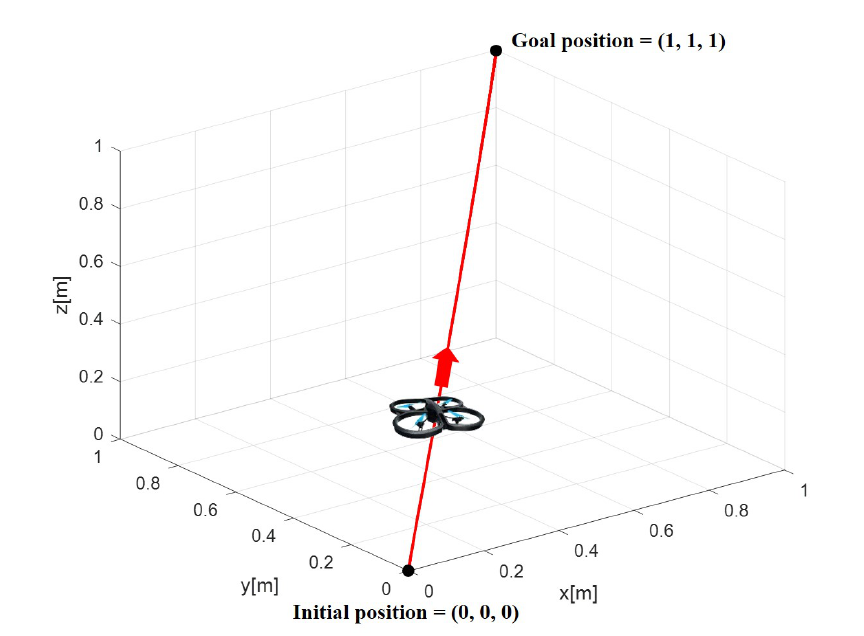
Figure 3. The inverse optimal position control when the initial and final states are (0, 0, 0) and (1, 1, 1), respectively.